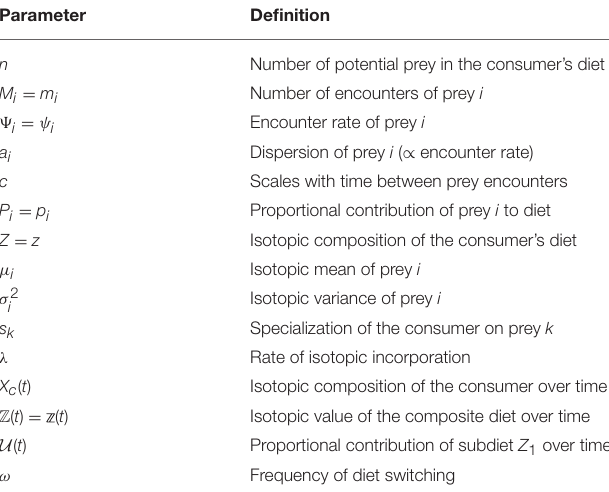
TABLE 1 | Parameters and their